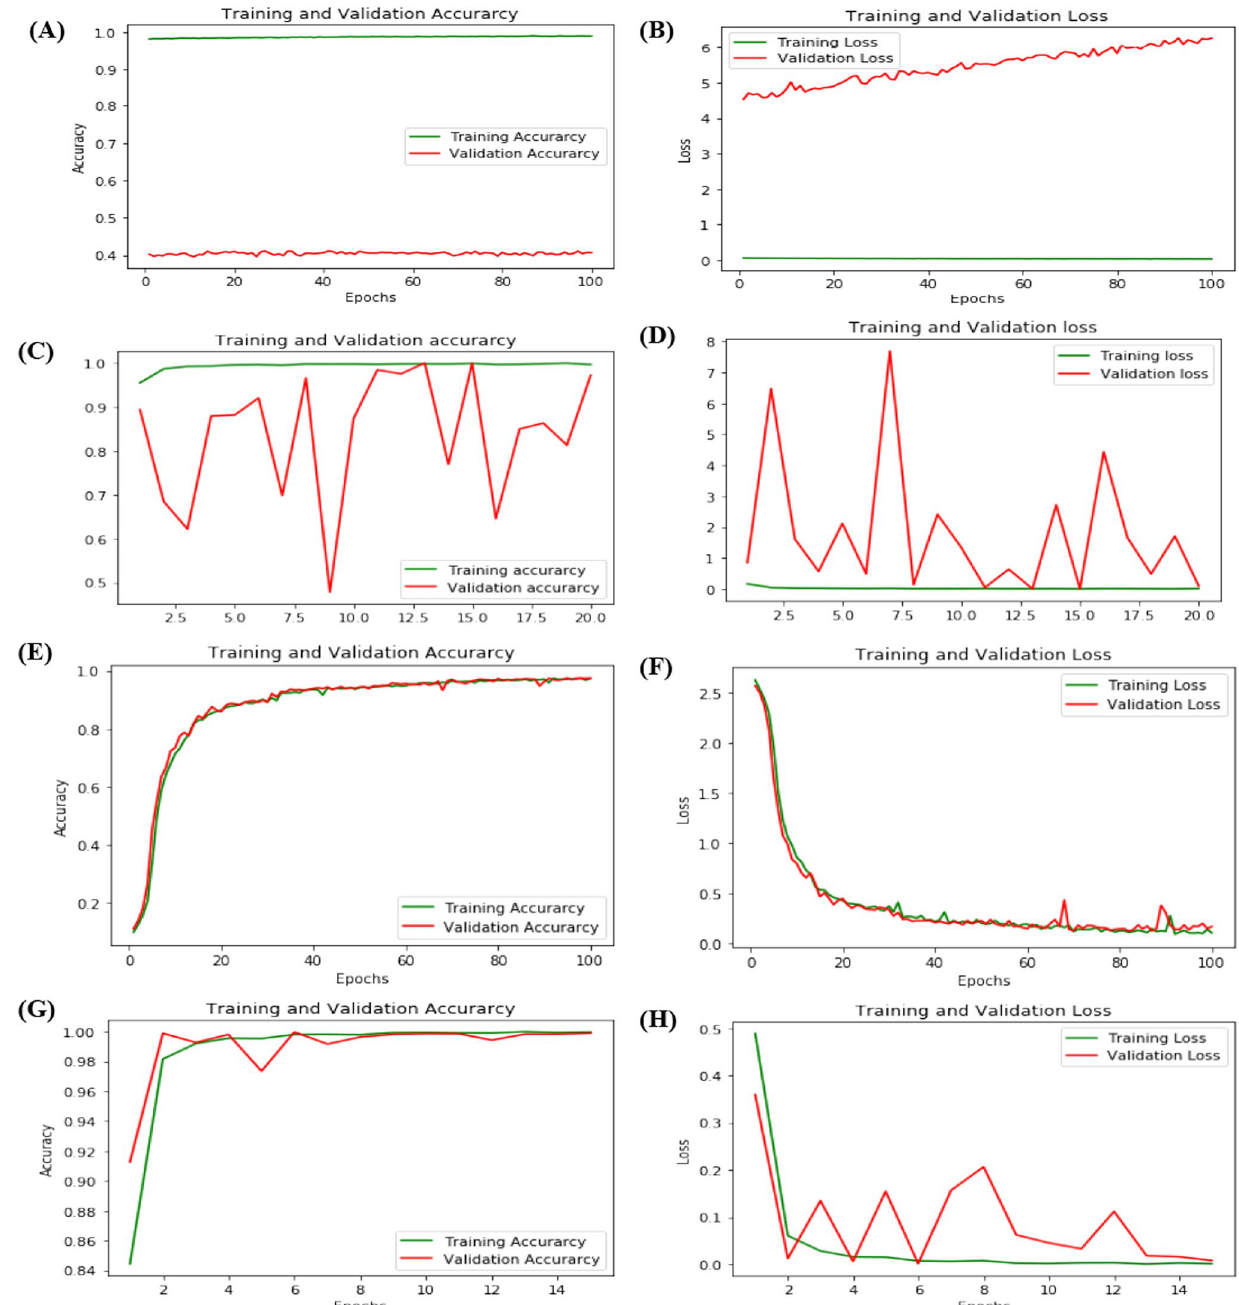
Fig. 2 Graphical representation for training and validation loss for studied CNN models. MobileNetV-2, VGG16, AlexNet, and modified ResNeXt—Validation accuracy ( A , C , E , and G ) and Validation loss ( B , D , F , and H